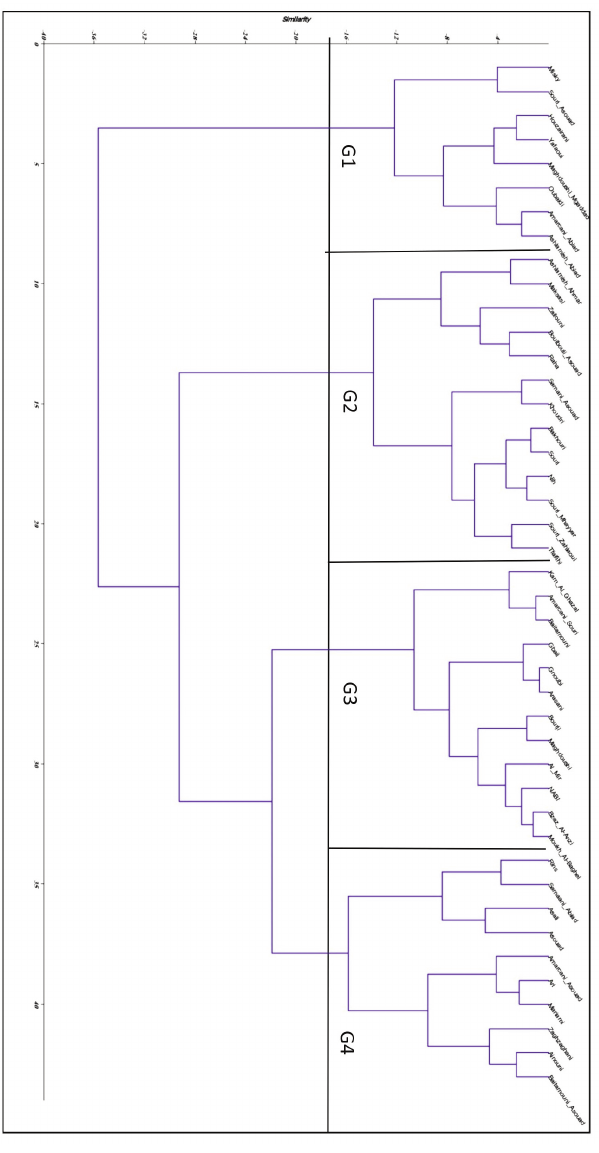
Fig. 4 ­ Hierarchical clustering analysis of the 43 Lebanese grape­ vine cultivars, based on the most 12 discriminant morphological traits, using Euclidean distance and Ward